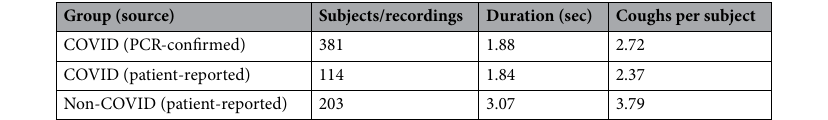
Table 1. Characterisation of the